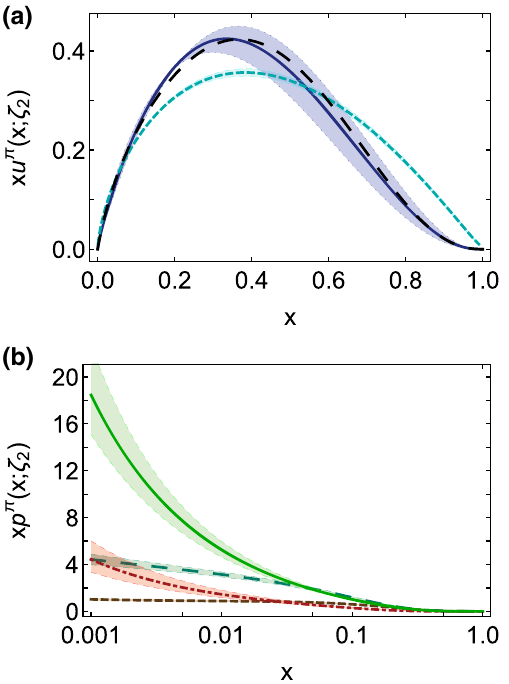
Fig. 4 a Solid blue curve – valence-quark distribution in Eq.(29) Fig. 3 a Solid blue curve: valence-quark distribution in Eq.(29) = 0 . 51GeV, using the procedure evolved to ζ = ζ 2 , using the procedure explained in Sect.4.1; long- evolved to the GRS-input scale, ζ LO 0 dashed black curve – result from Ref. [102]; and short-dashed cyan explained in Sect.4.1. Dashed blue curve: GRS input distribution at this – phenomenological result from Ref. [52], also at ζ = ζ 2 . b Solid scale [51]. b Solid green curve, p = g —our prediction for the pion’s green curve, p = g – our prediction for the pion’s glue distribution; glue distribution; and dot-dashed red curve, p = S —predicted sea- and dot-dashed red curve, p = S – predicted sea-quark distribution. quark distribution. The long-dashed green curve and dotted red curve Phenomenological results from Ref. [52] are plotted for comparison: are the GRS input distributions: p = g and p = S , respectively. ) + g π ( x ; ζ LO ) + p = glue – long-dashed dark-green; and p = sea – dashed brown. Nor- In our normalisation convention, (cid:2) x [ 2 u π ( x ; ζ LO 0 0 malisation convention: (cid:2) x [ 2 u π ( x ; ζ 2 ) + g π ( x ; ζ 2 ) + S π ( x ; ζ 2 ) ](cid:3) = 1. ) ](cid:3) = 1. (The uncertainty bands bracketing our results are S π ( x ; ζ LO 0 Notably, 2 u π ( x ; ζ 2 ) > [ g π ( x ; ζ 2 ) + S π ( x ; ζ 2 ) ] on x > 0 . 2, explained following Eq.(31))